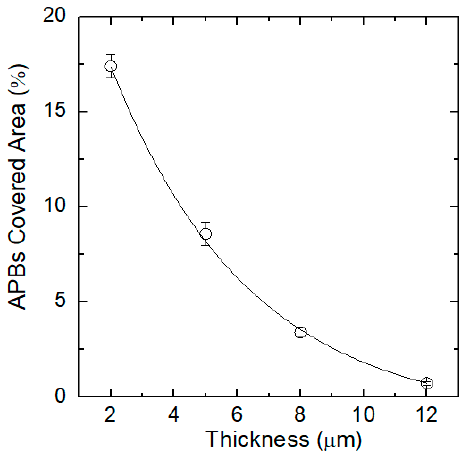
Figure 5. Anti-phase boundaries (APBs) covered area percentages for different thicknesses of epitaxial growth.